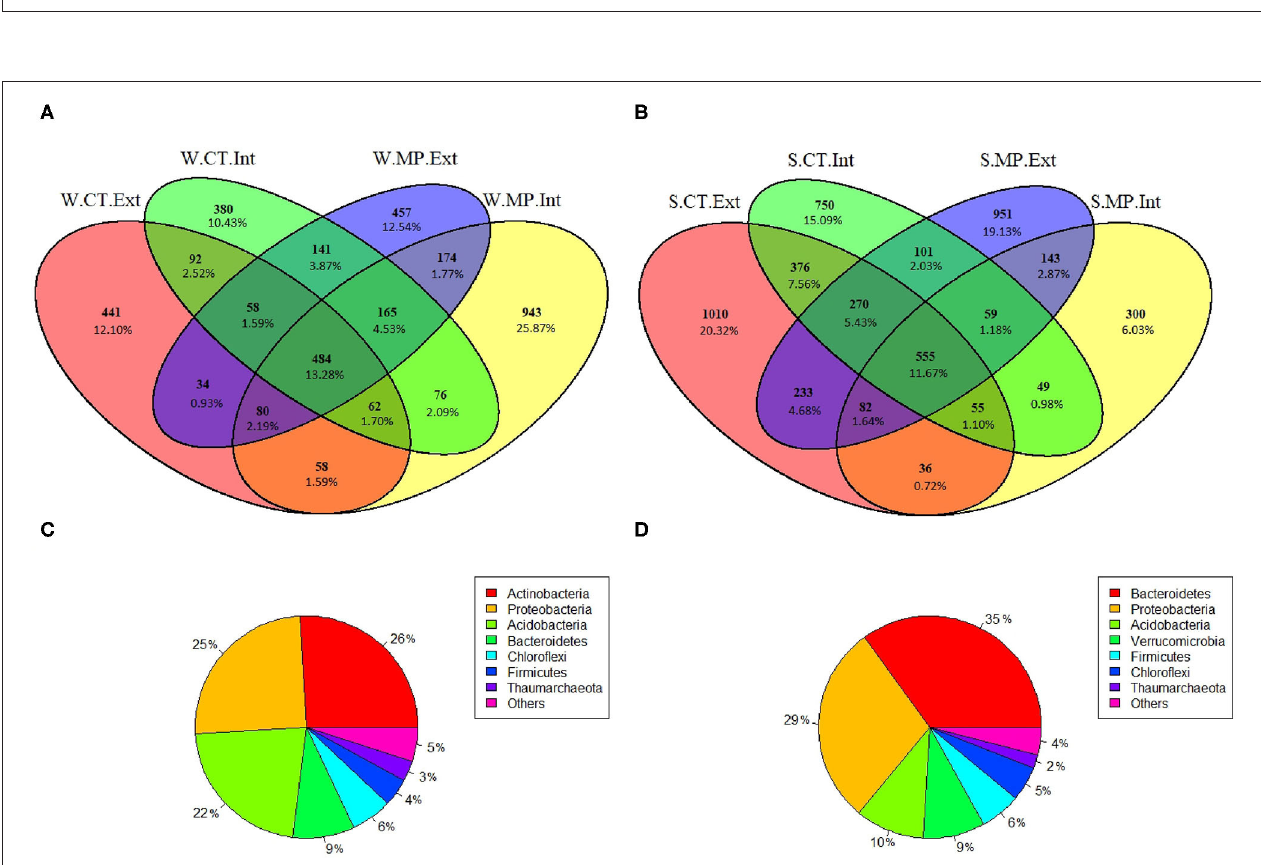
FIGURE 5 | Venn Diagrams (A,B) showing unique and shared bacterial/archaeal ASVs among soils sampled in LTE Bernburg in winter (W) or summer (S) under different long-term tillage practices (CT, Cultivator Tillage vs. MP, Moldboard Plow) and N-fertilization intensities (Int, intensive vs. Ext, extensive). Taxonomic classification (C,D) at the phylum level of ASVs shared among all four treatments in winter or summer, respectively.